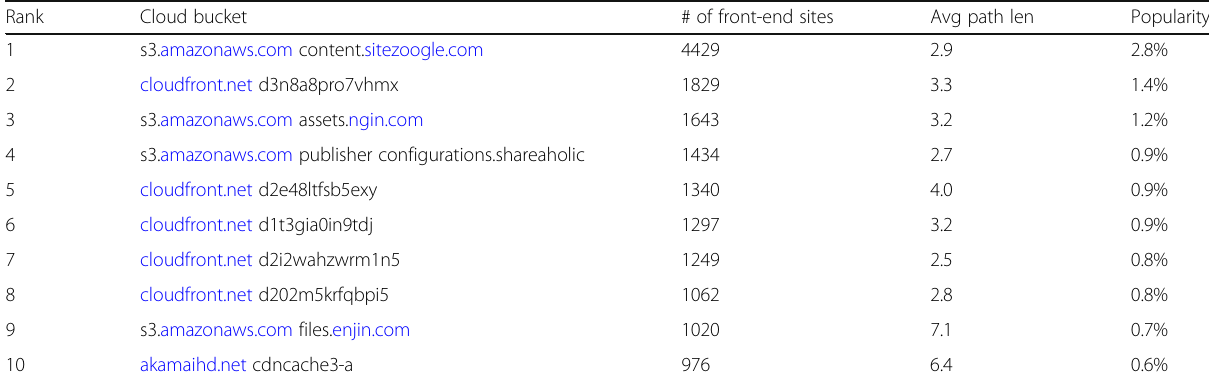
Table 5 Top 10 most popular